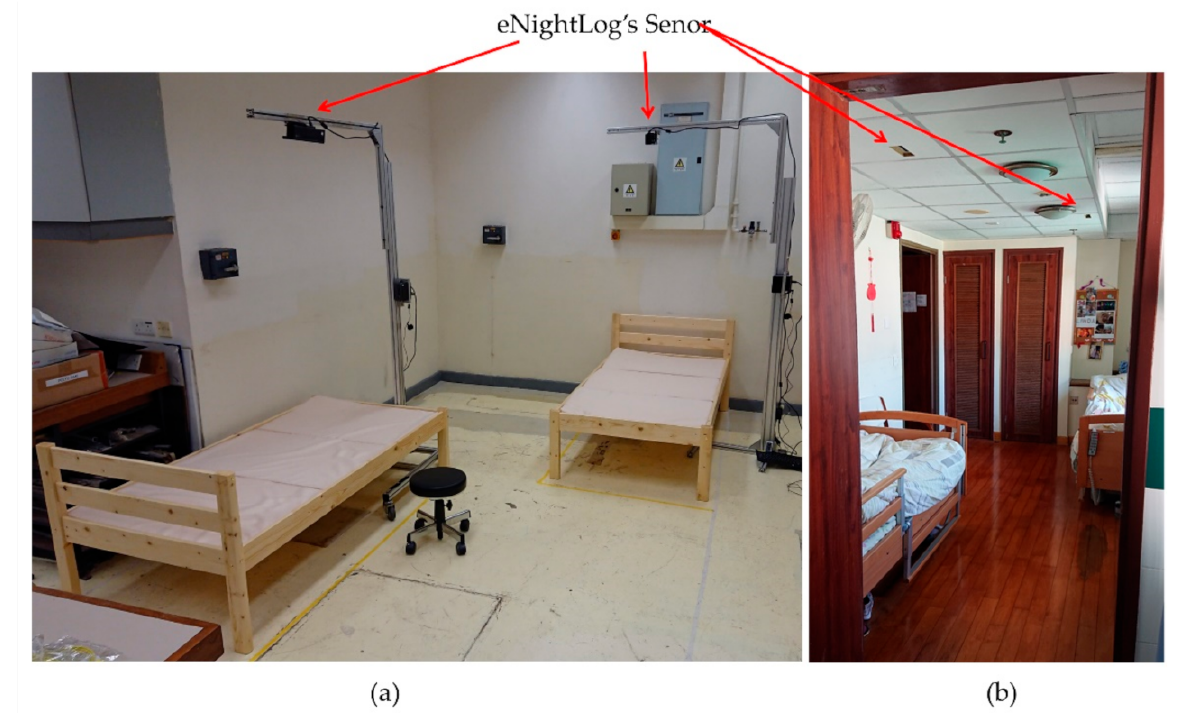
Figure 6. ( a ) Simulated double-bed setting with tapes on the ground to denote the walls and entries; ( b ) The actual double-bed room in the hostel served as the setting in this experiment.